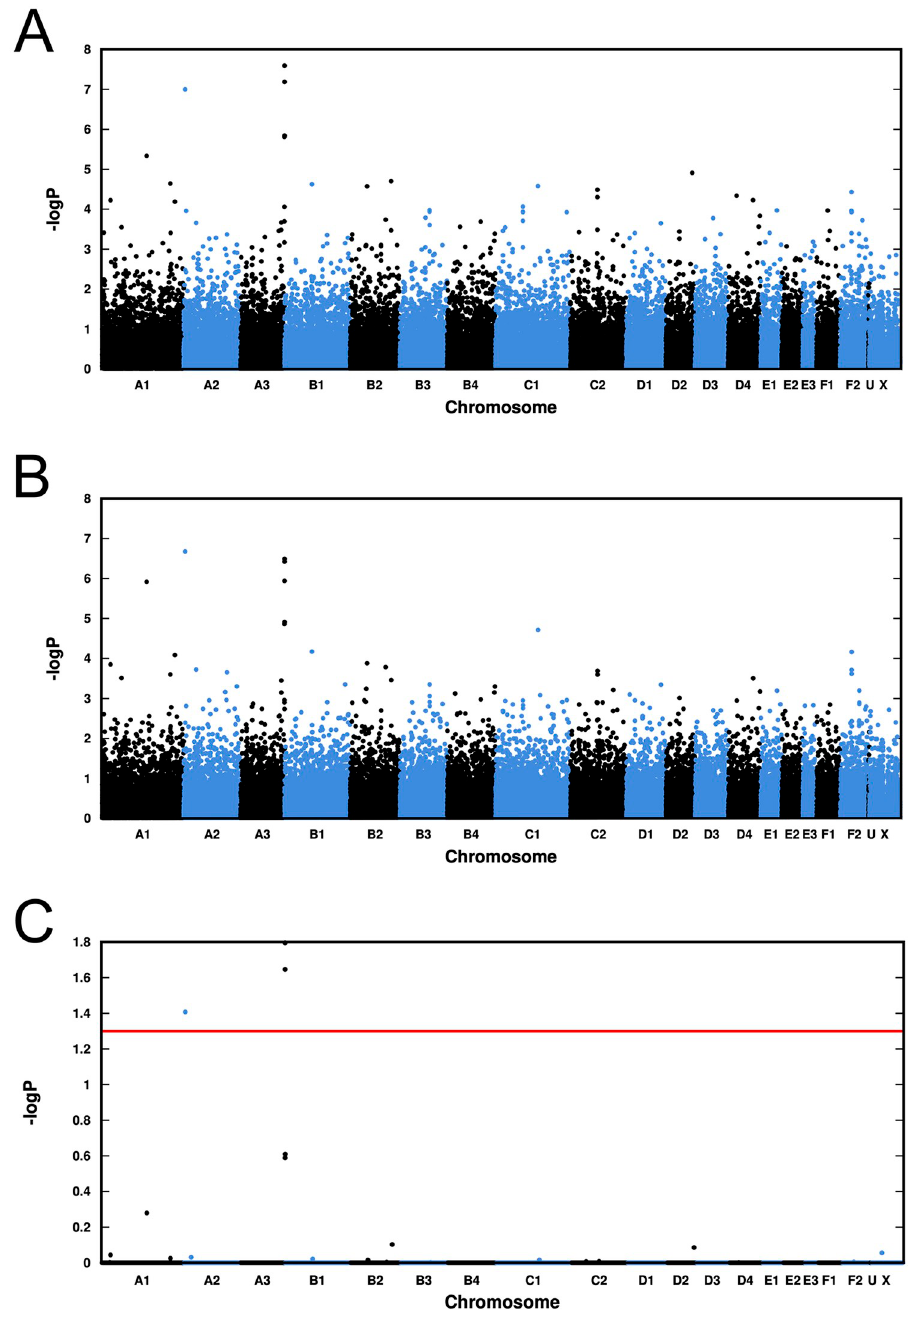
Fig 3. Association plots of our case-control genome-wide association analysis. A) Standard association plot of p raw values. B) Plot of EMMAX-corrected association values. (C) Plot of p genome values after correction for multiple testing by the mperm option of PLINK. The red horizontal line shows the p = 0.05 level of significance. In all plots the chromosome marked “U” contains SNPs which are mapped to the new assembly but not to one of the standard